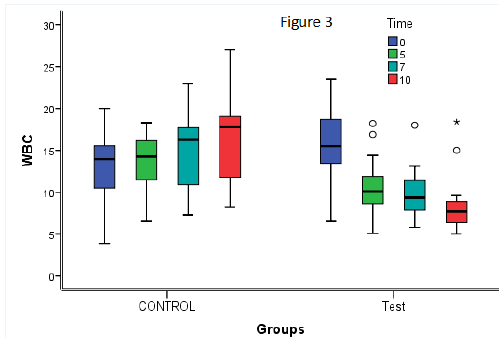
Fig. 3. White blood cell count (WBC) between the control and the test